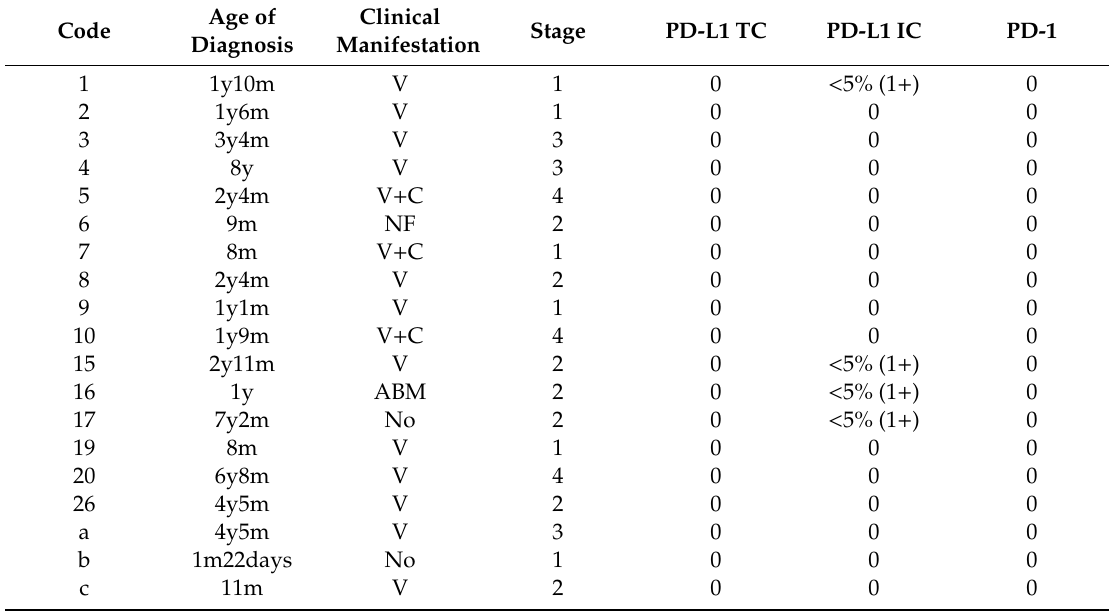
in Table 1. a, b, and c, other patients. TC: tumor cells, IC: immune cells.